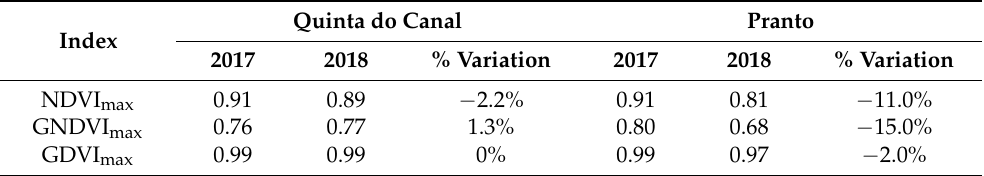
Table 5. Vegetation Indices’ maximum values attained during the 2017 and 2018 rice cultivation seasons at the plot scale, for the Quinta do Canal and Pranto rice fields, and respective percent- age